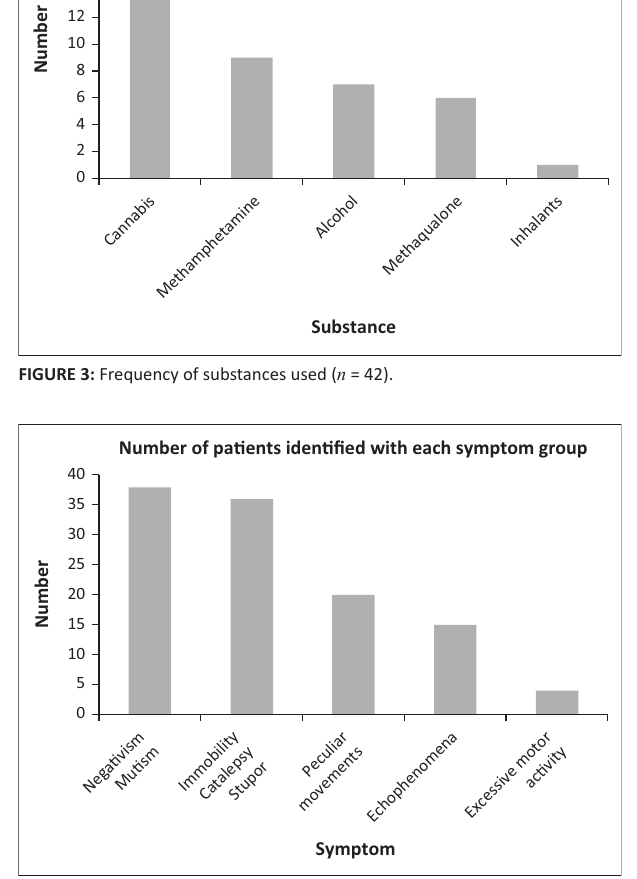
FIGURE 4: Clinical features of catatonia ( n =